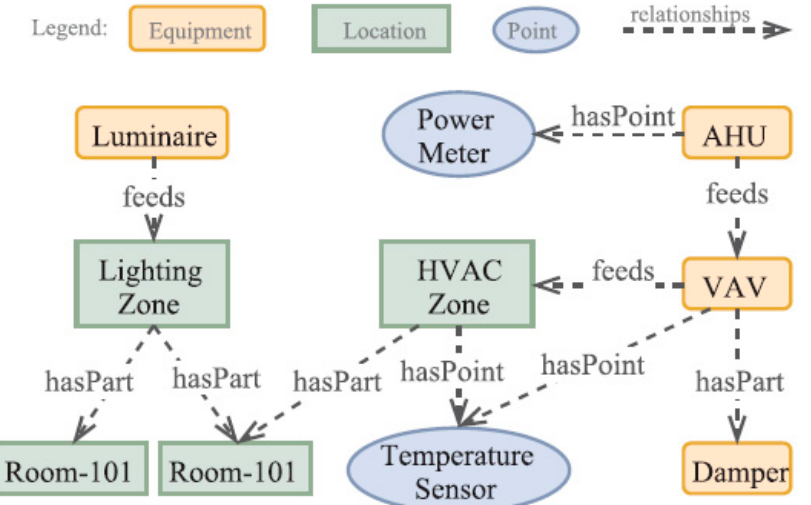
Figure 10. Brick classes and relationships for a subset of the example building in Figure 9